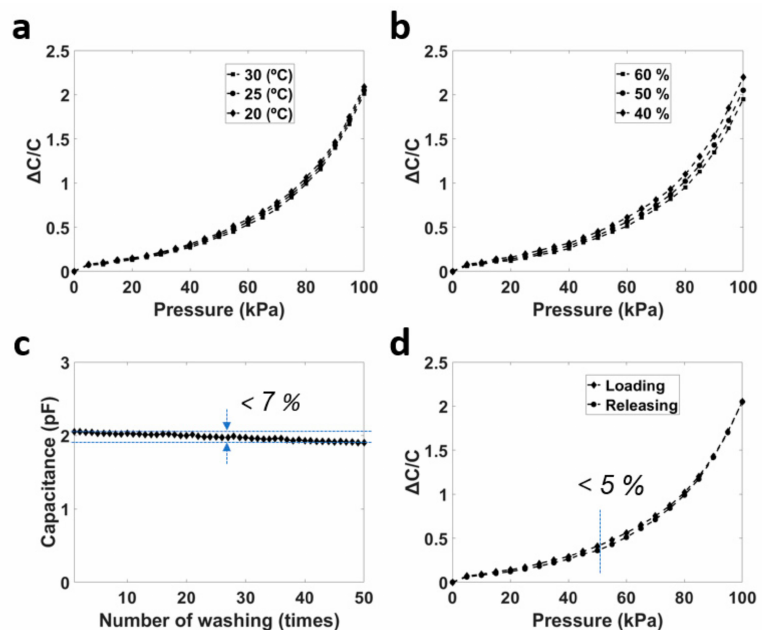
Figure 7. ( a ) Relative change in the capacitance under temperature from 20 to 30 ◦ C, ( b ) relative change in the capacitance under humidity from 40 to 60%, ( c ) the capacitance of sensors at 100 kPa after 50 washing times, and ( d ) hysteresis of the sensor at 100